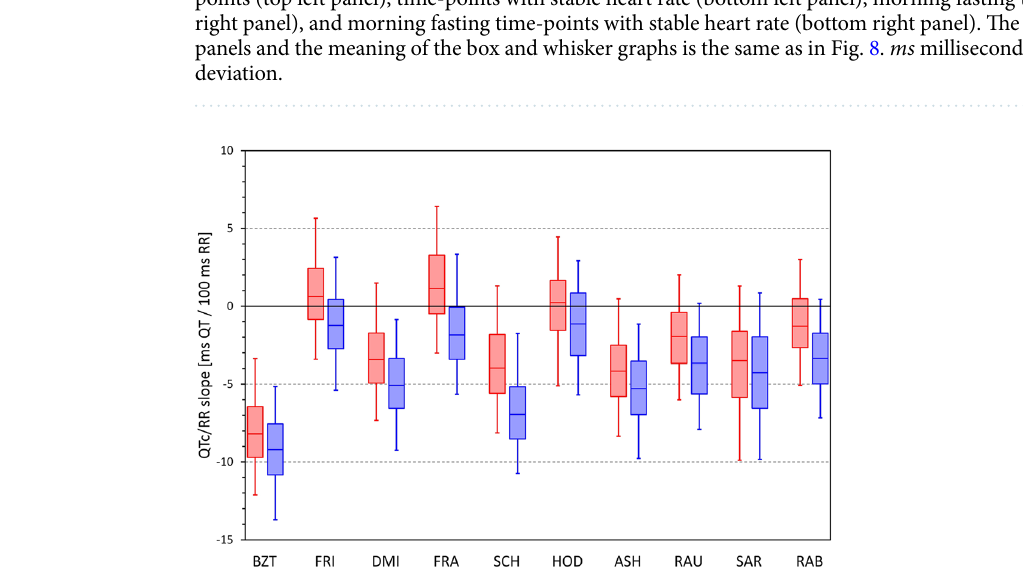
Figure 10. Distribution of intra-subject linear slopes between QTc values and corresponding 10-s averages of RR intervals calculated over all ECG reading during the baseline drug-free day. The layout of the panel and the meaning of the box and whisker graphs is the same as in Fig. 8. ms